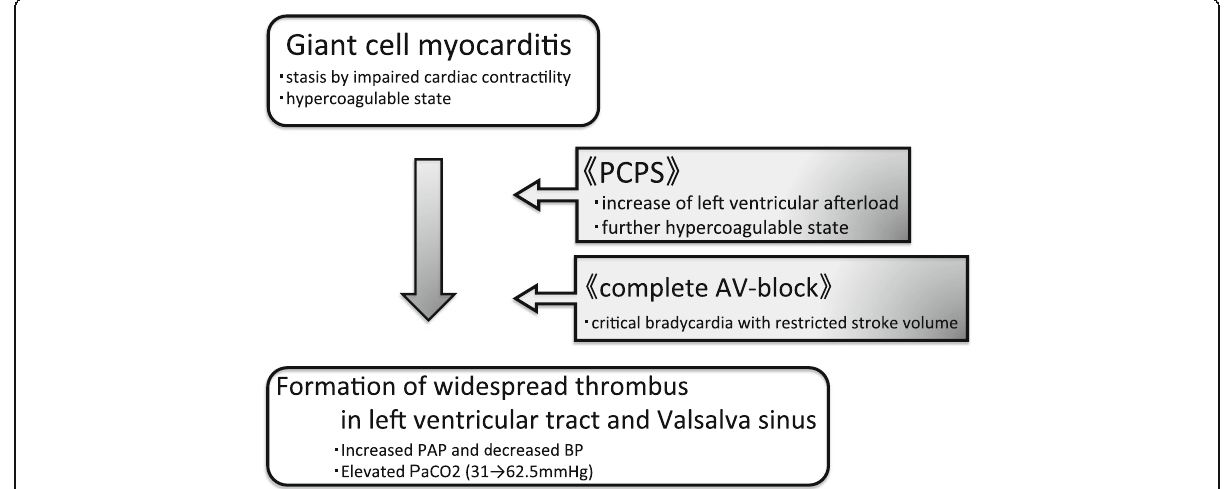
Fig. 6 The mechanism of thrombus formation in this case. PCPS percutaneous cardiopulmonary support, AV-block atrioventricular block, BP systemic blood pressure, PAP pulmonary artery pressure, PaCO 2 arterial carbon dioxide tension. Giant cell myocarditis induced the left ventricular distension and subsequent thrombus formation tendency. The retrograde perfusion by the PCPS and the complete atrioventricular block further enhanced thrombus formation tendency. As a result, widespread thrombi were formed in the left ventricular tract and the Valsalva